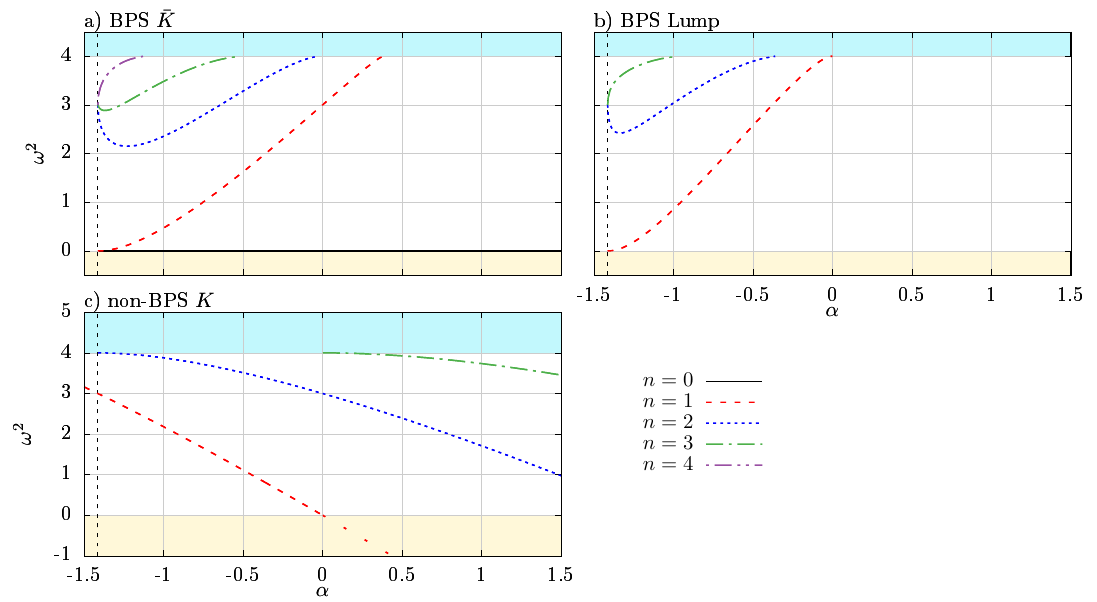
Figure 11 . Spectral structure of the antikink (left), the lump (right) and the kink